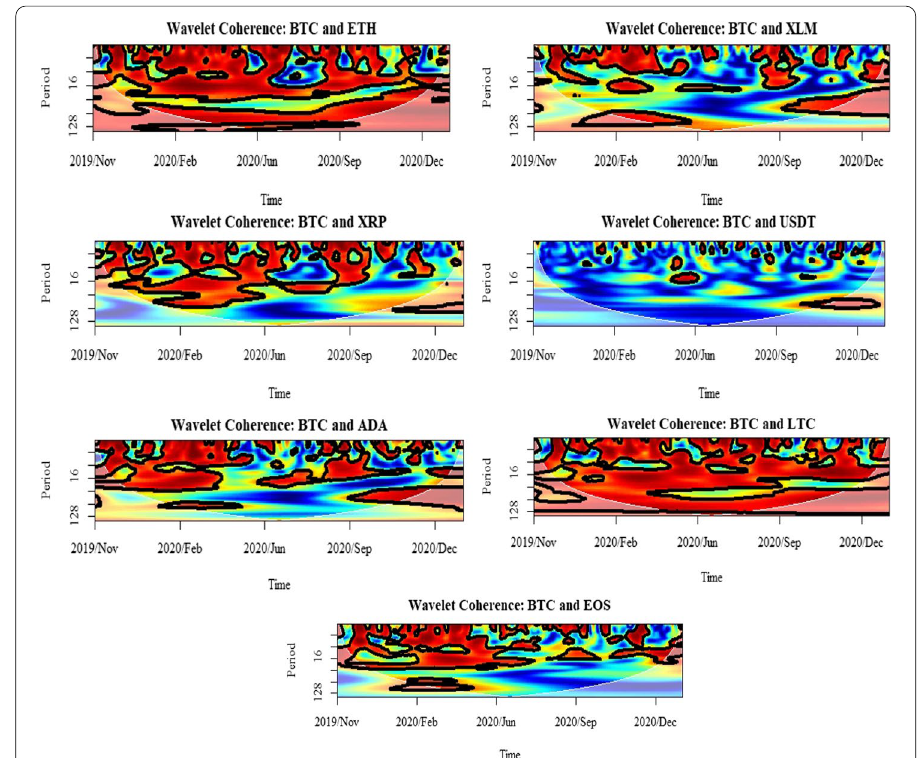
Fig. 6 Results for wavelet coherence: BTC